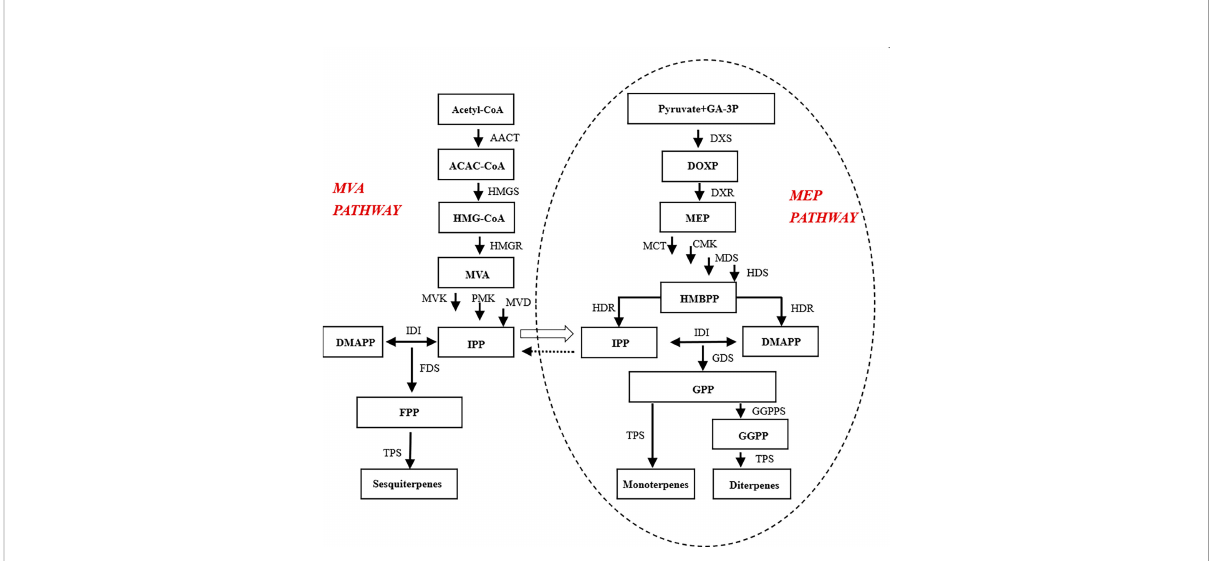
FIGURE 5 Important transcription factors in the terpenoid synthesis pathway of ‘ Taihang Mingzhu ’